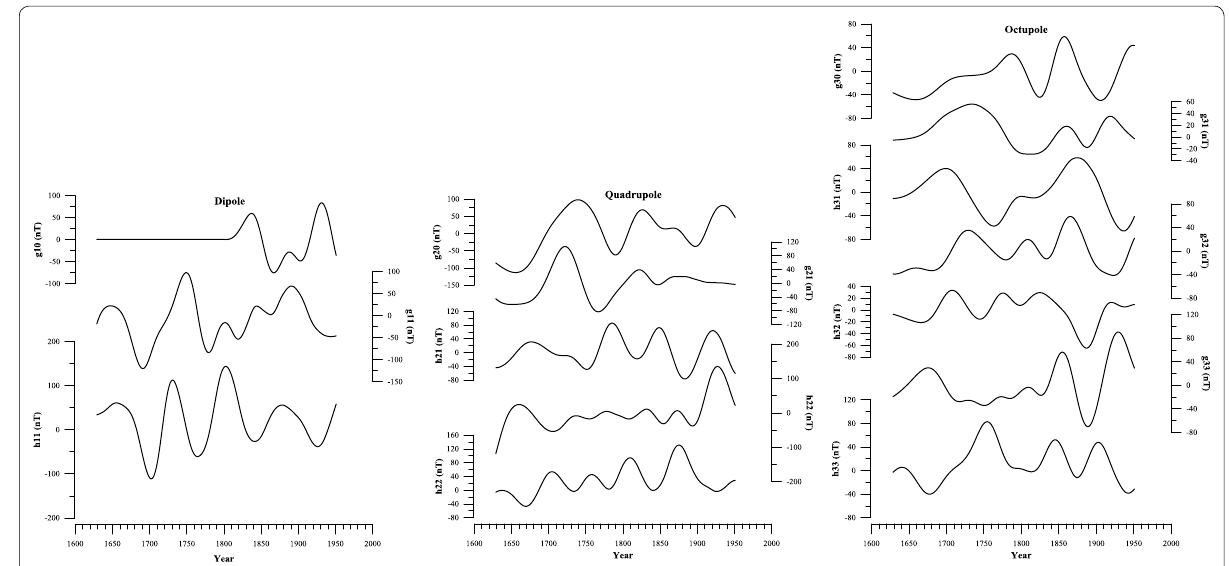
Fig. 9 The sub-centennial constituent of gufm1 Gauss coefficients time evolution, degree n